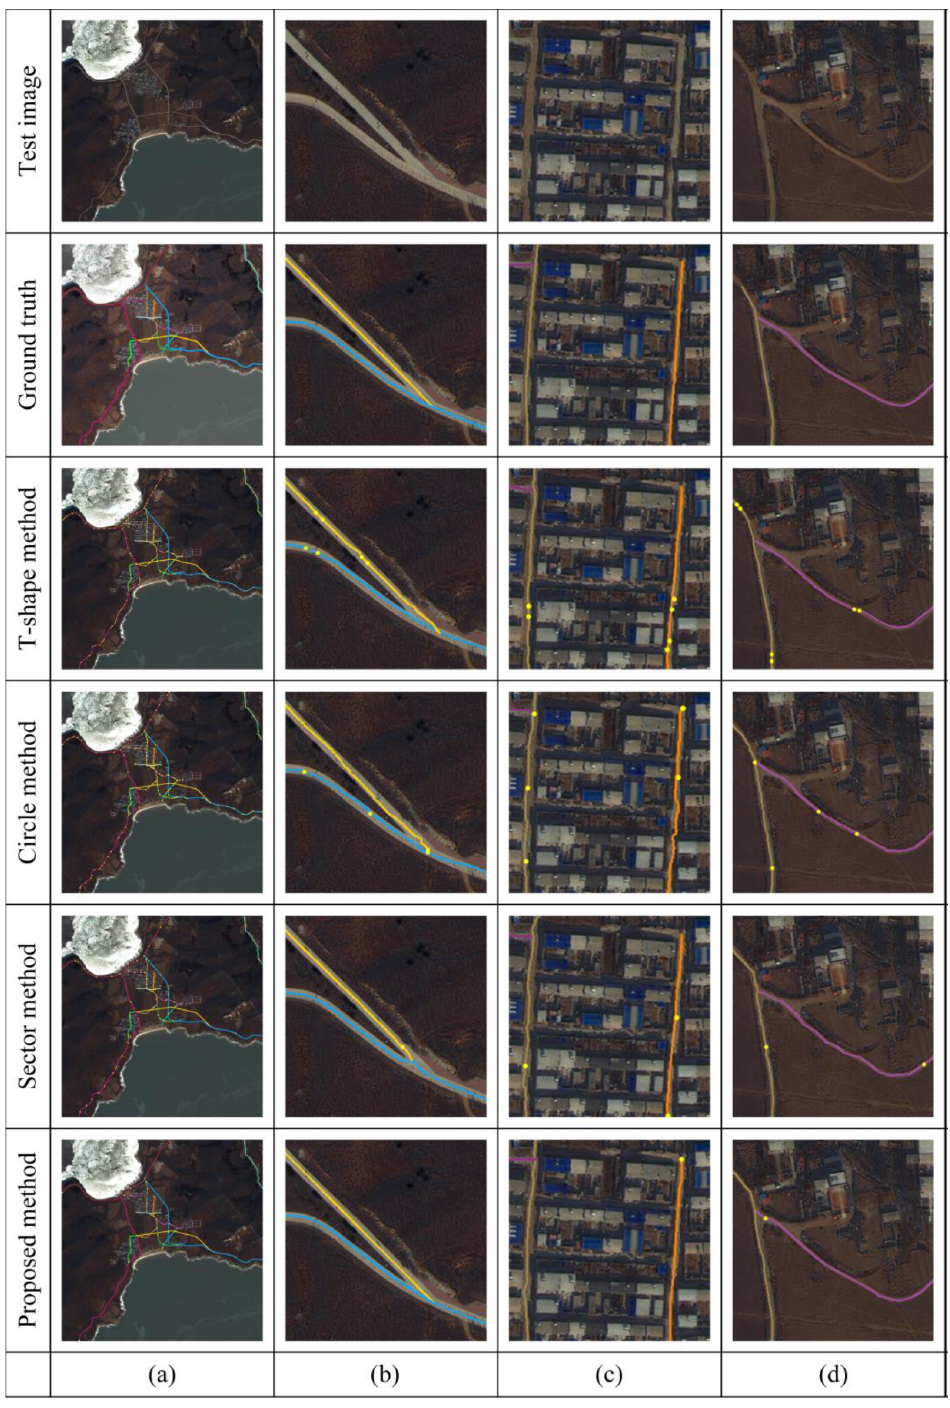
Figure 17. This is a figure. The results of road extraction with different algorithms in the rural island area of Pleiades (different colored curves represent different routes).